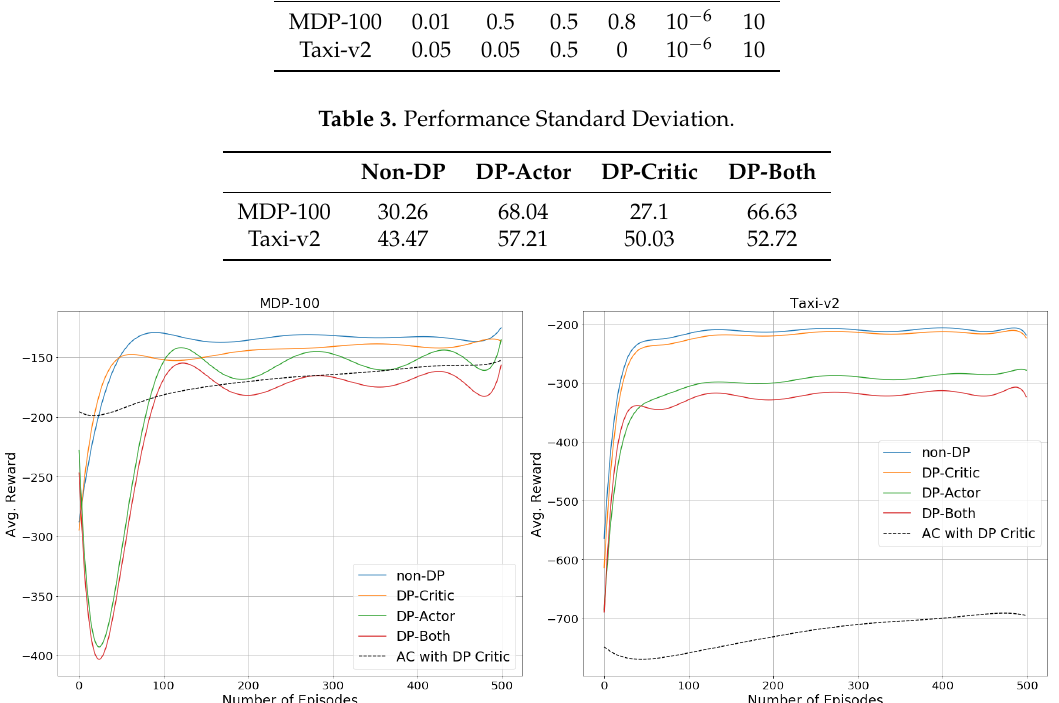
Figure 2. Learning curves in two synthetic examples (MDP-100, Taxi-v2). We choose the optimal parameter combination among all of the combinations after averaging 10 runs for each parameter